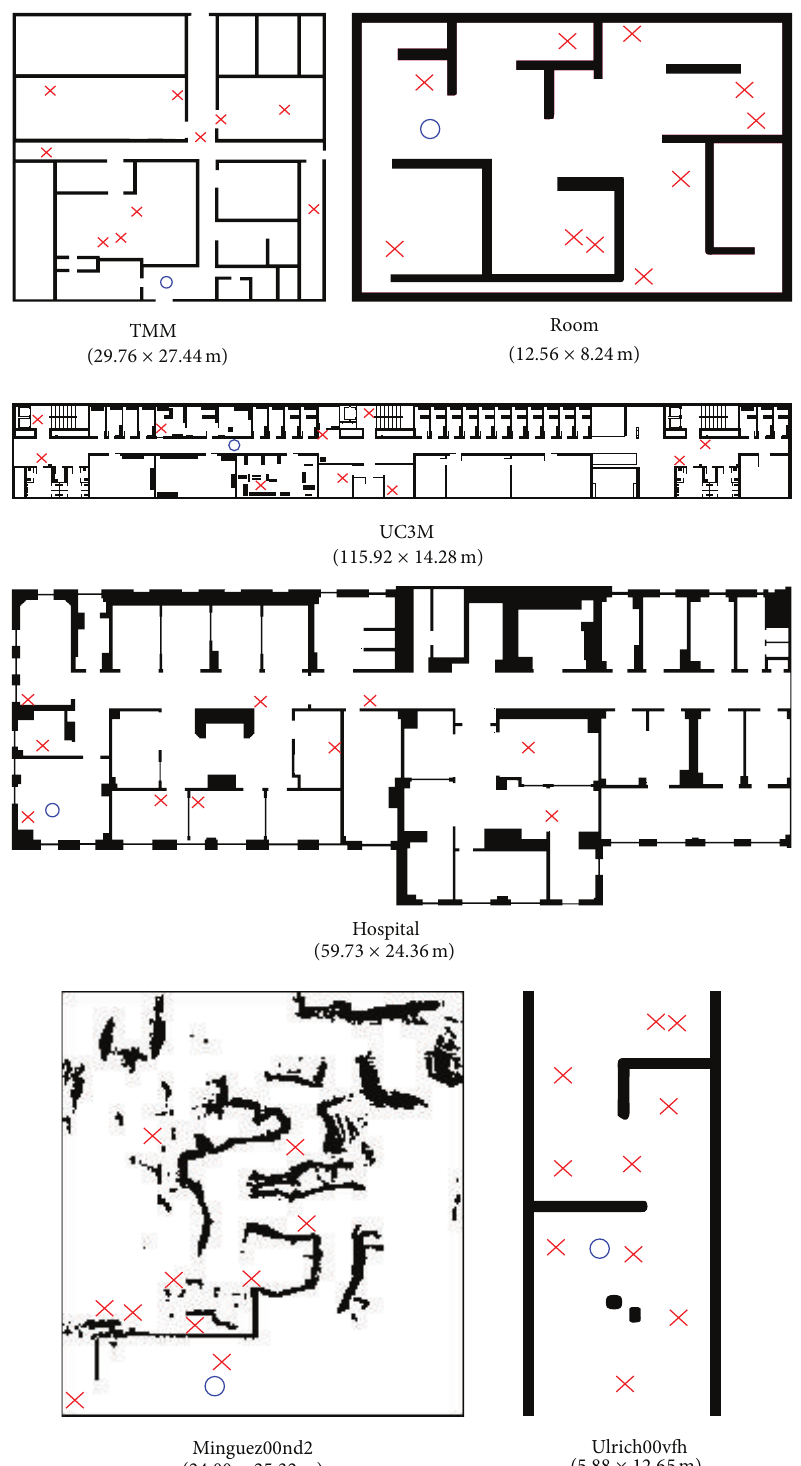
Figure 7: Trajectories starting and end